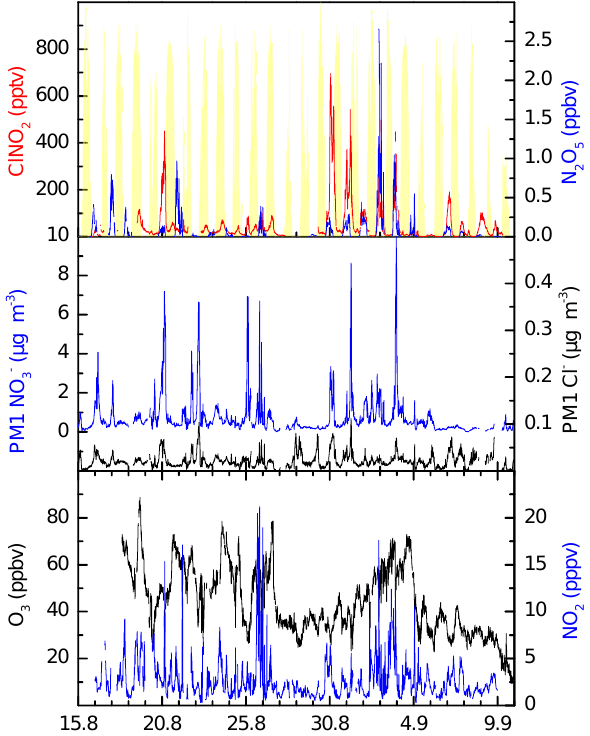
Figure 3. Time series of ClNO 2 and its precursor, N 2 O 5 . Global radiation (yellow) is plotted to separate day-to-night periods and to indicate the day-to-day relative photochemical activity. The precur- sors to N 2 O 5 (NO 2 and O 3 ) are shown as are the AMS measure- ment of particulate nitrate (as in Fig. 2) and